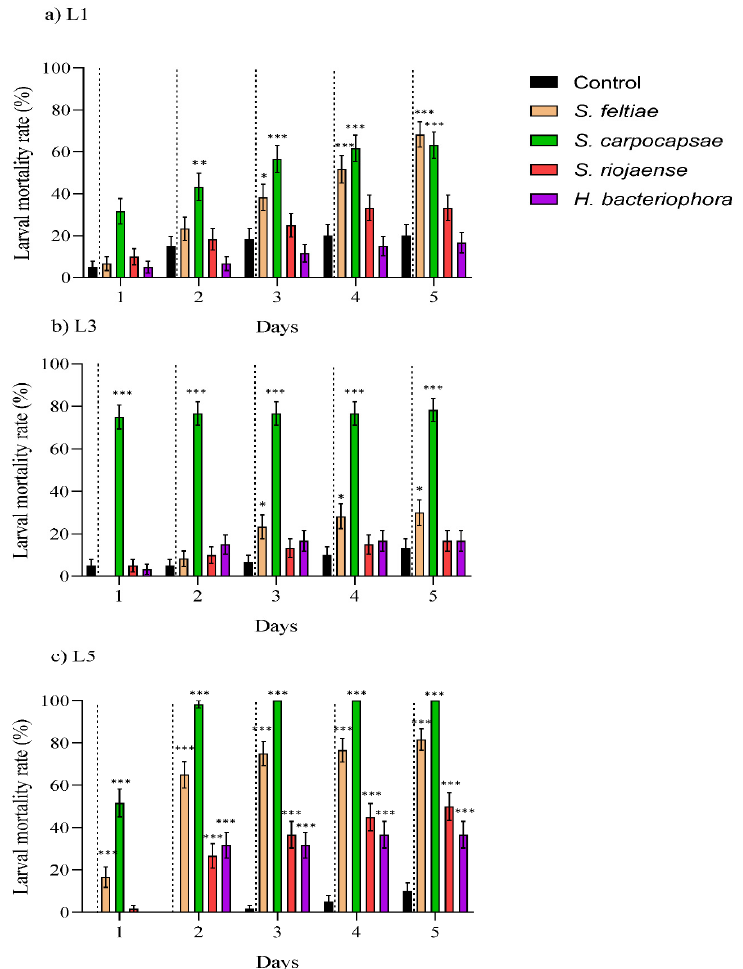
Figure 1. Virulence of the entomopathogenic nematodes species Steinernema feltiae , S. carpocapsae , S. riojaense , and Heterorhabditis bacteriophora against various larval instars the European grapevine moth, Lobesia botrana . ( a ) First instar (L1), ( b ) third instar (L3), and ( c ) fifth instar (L5). Data are presented in days (from 1 up to 5 days, x-axis) and measured as larval mortality rate (%) (y-axis). Asterisks indicate significant differences at *** p <0.001, ** p <0.01, * p <0.05. Values are least-square means ± SE.